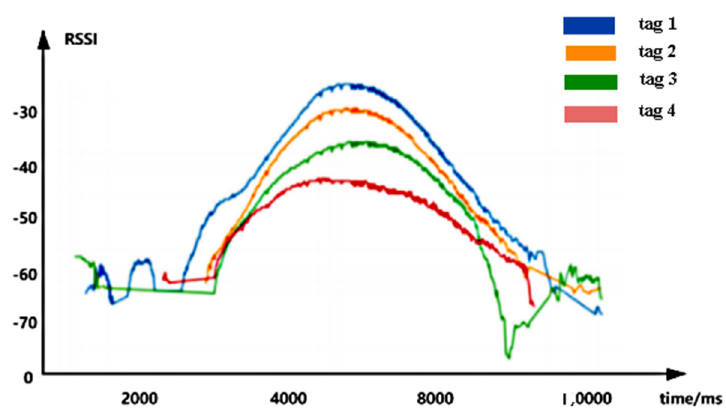
Figure 2. Variation rule of the received signal strength (RSSI) of tags in the same column.